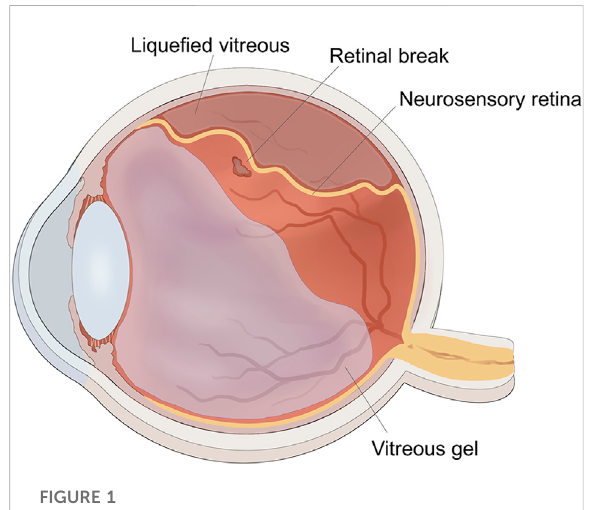
FIGURE 1 The schematic diagram of rhegmatogenous retinal detachment. The traction of vitreous gel onto retina created the retinalbreak,liqui fi edvitreouspenetratedintothesubretinalspace through the retinal break to induce retinal